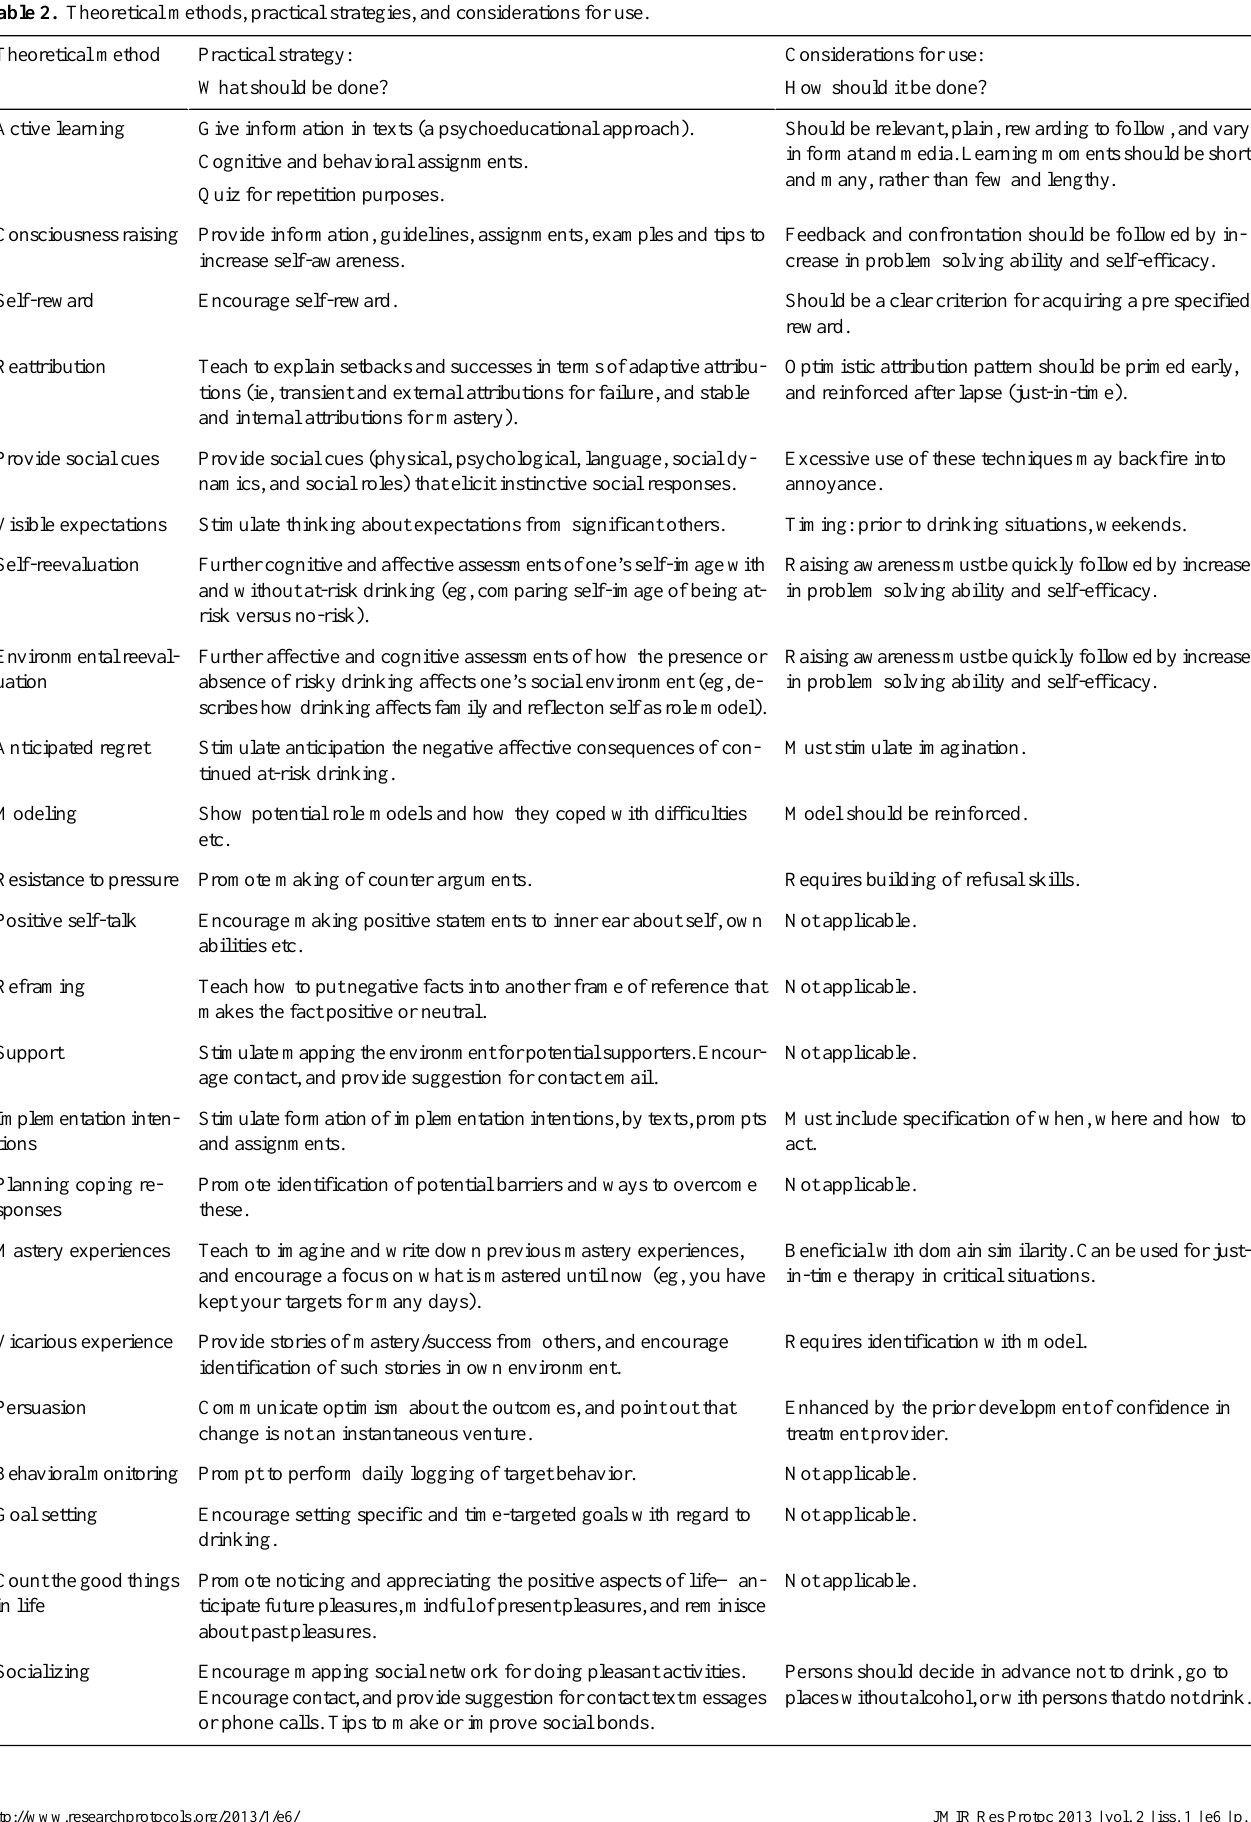
Table 2. Theoretical methods, practical strategies, and considerations for use.